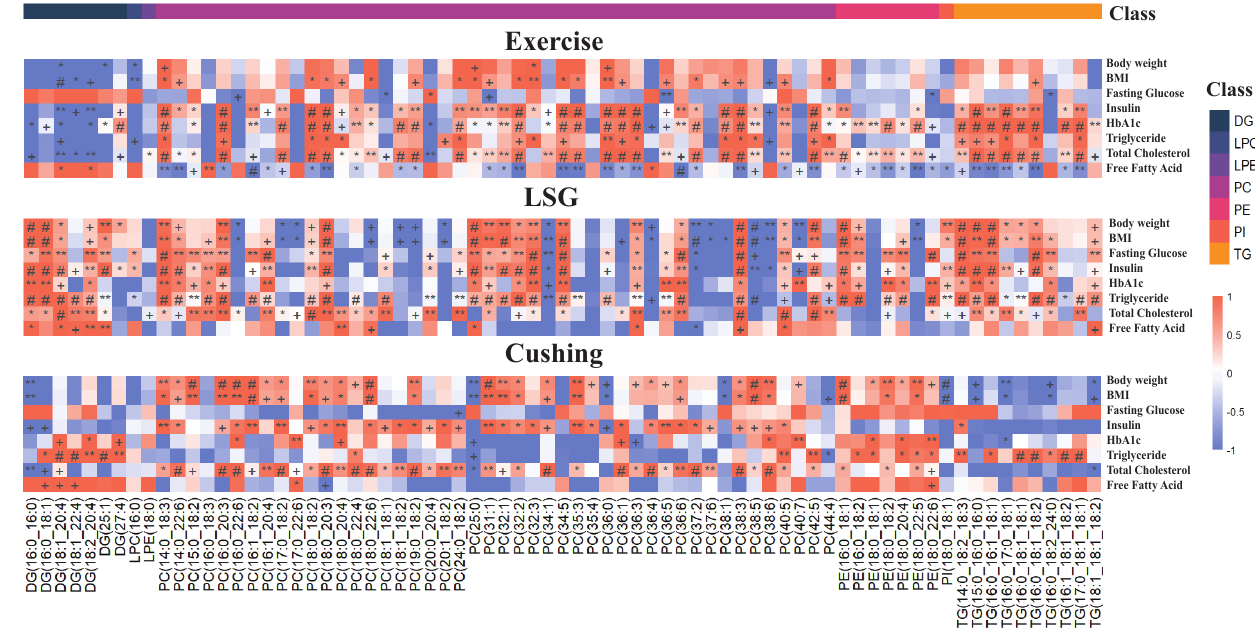
Figure 6. Correlations between lipid species and clinical characteristics in Exercise, LSG, and Cushing. Spearman correlations computed between lipid species and clinical features, + p < 0.1, * p < 0.05,